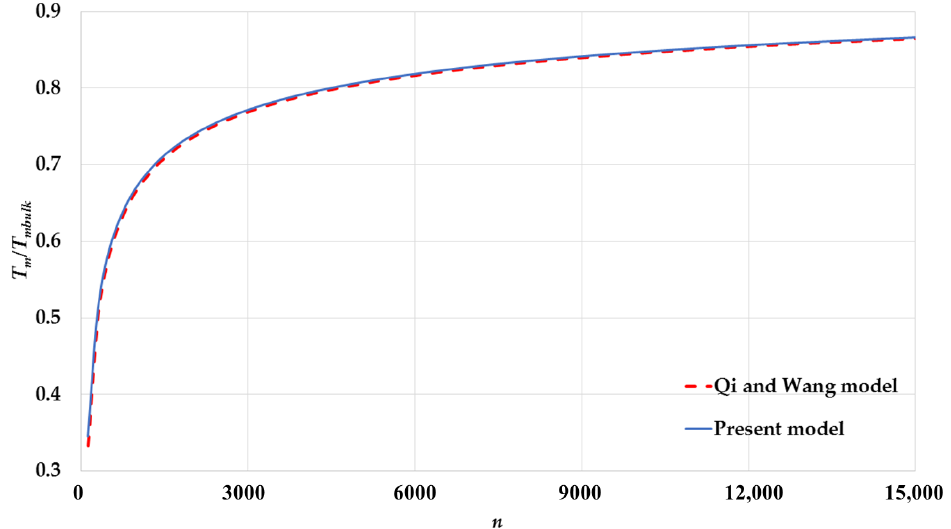
Figure 7. The variation of ratio T m / T mbulk as function of number of atoms n of spherical nanoparticles in an FCC structure using the present model and compared to Qi and Wang model [24].